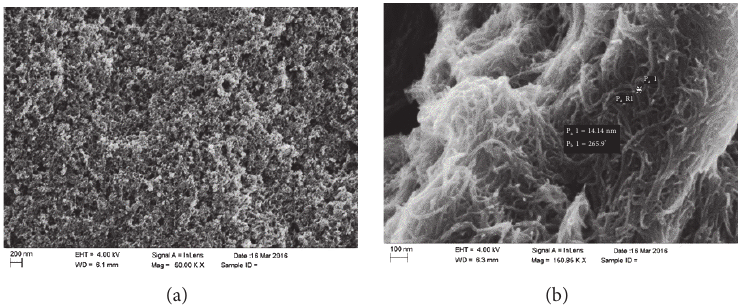
Figure 5: SEM images of electrodes surfaces: MG-SPE bare (a) and NAF-MWCNTs-COOH-MG-SPE modified electrode (b).